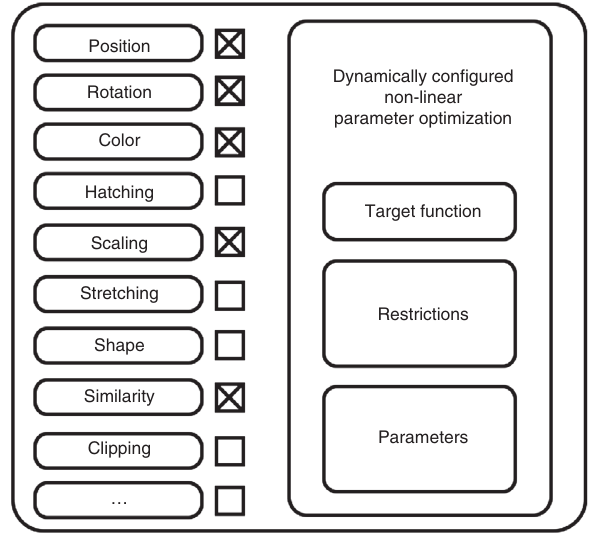
Figure 4. Dynamically Configured Non-Linear Parameter Optimization.